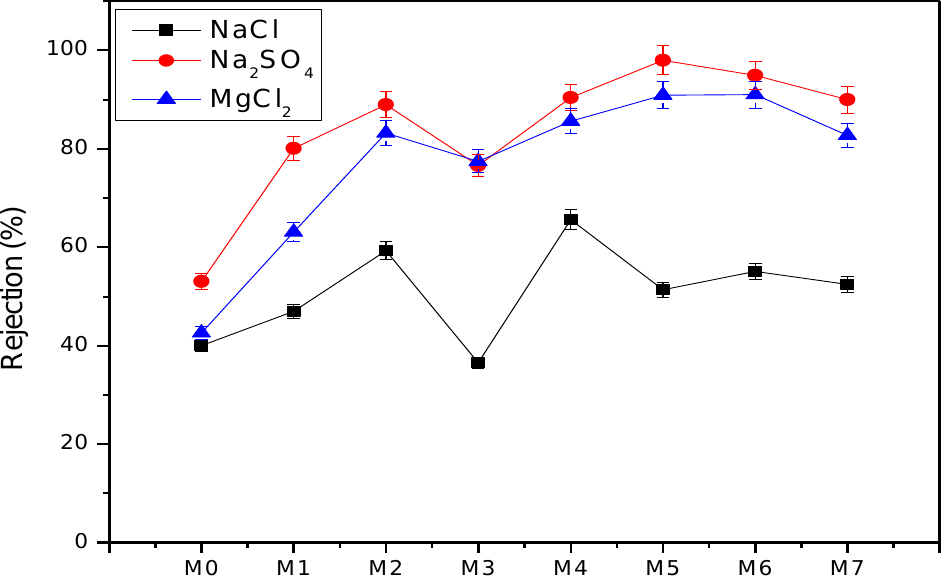
Figure 14. Salt rejection performance of the prepared membranes exhibiting the effects of GO and ZIF-8 on mono- and multivalent ions.